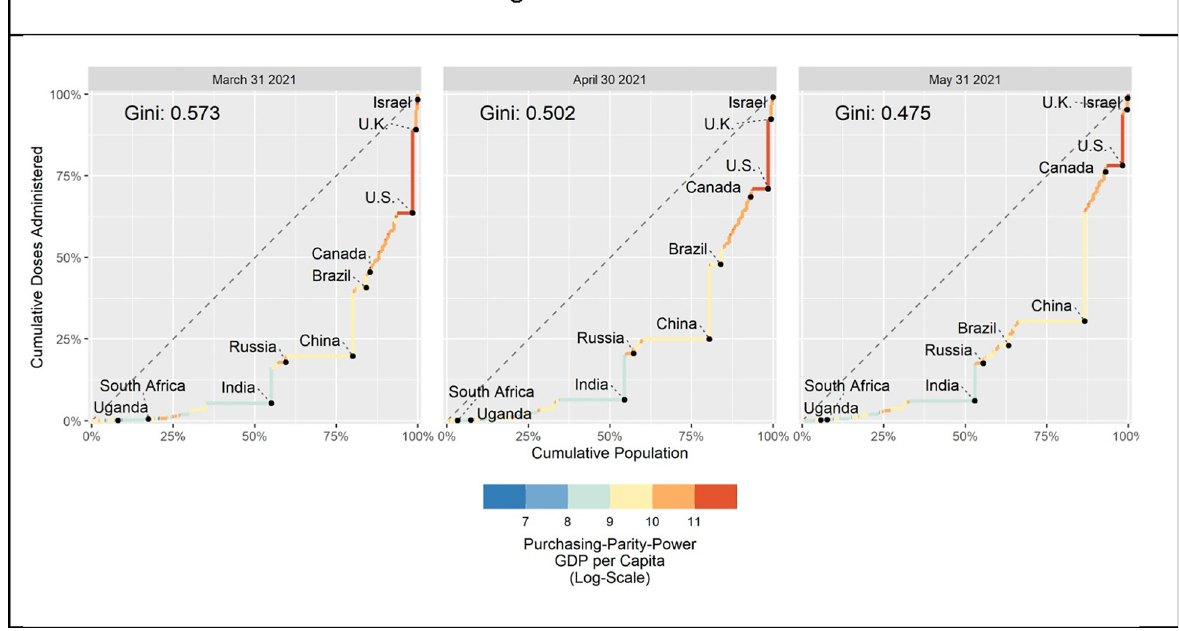
Fig 1. Lorenz curve and Gini coefficient as examples of potential metrics explicitly depicting equity of global distribution of COVID-19 vaccine. COVID-19, Coronavirus Disease 2019; GDP, gross domestic product.